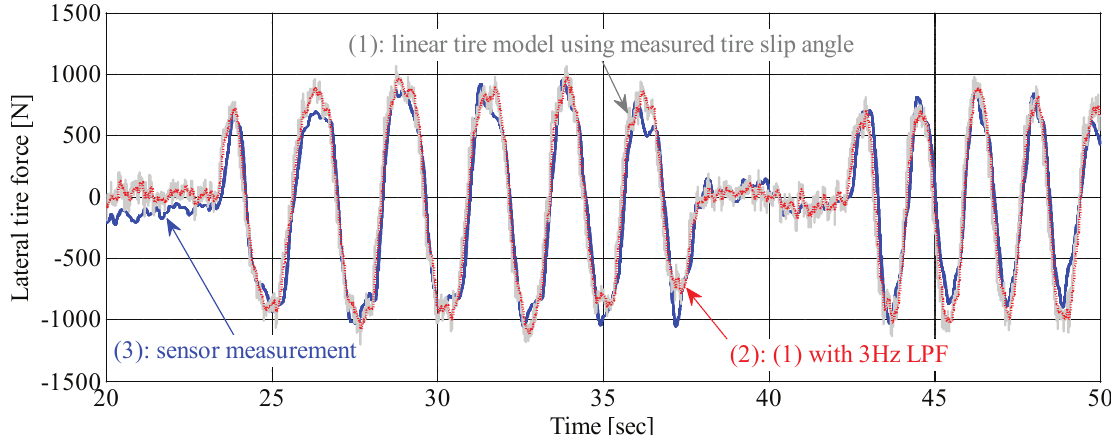
Figure 2. Lateral tire force measurement: (1) calculated force from a linear tire force model using measured tire slip angle and nominal tire cornering stiffness; (2) processed force of (1) using a low-pass filter with a cutoff-frequency of 3 Hz; (3) sensor measurement from a load-sensing hub bearing unit.